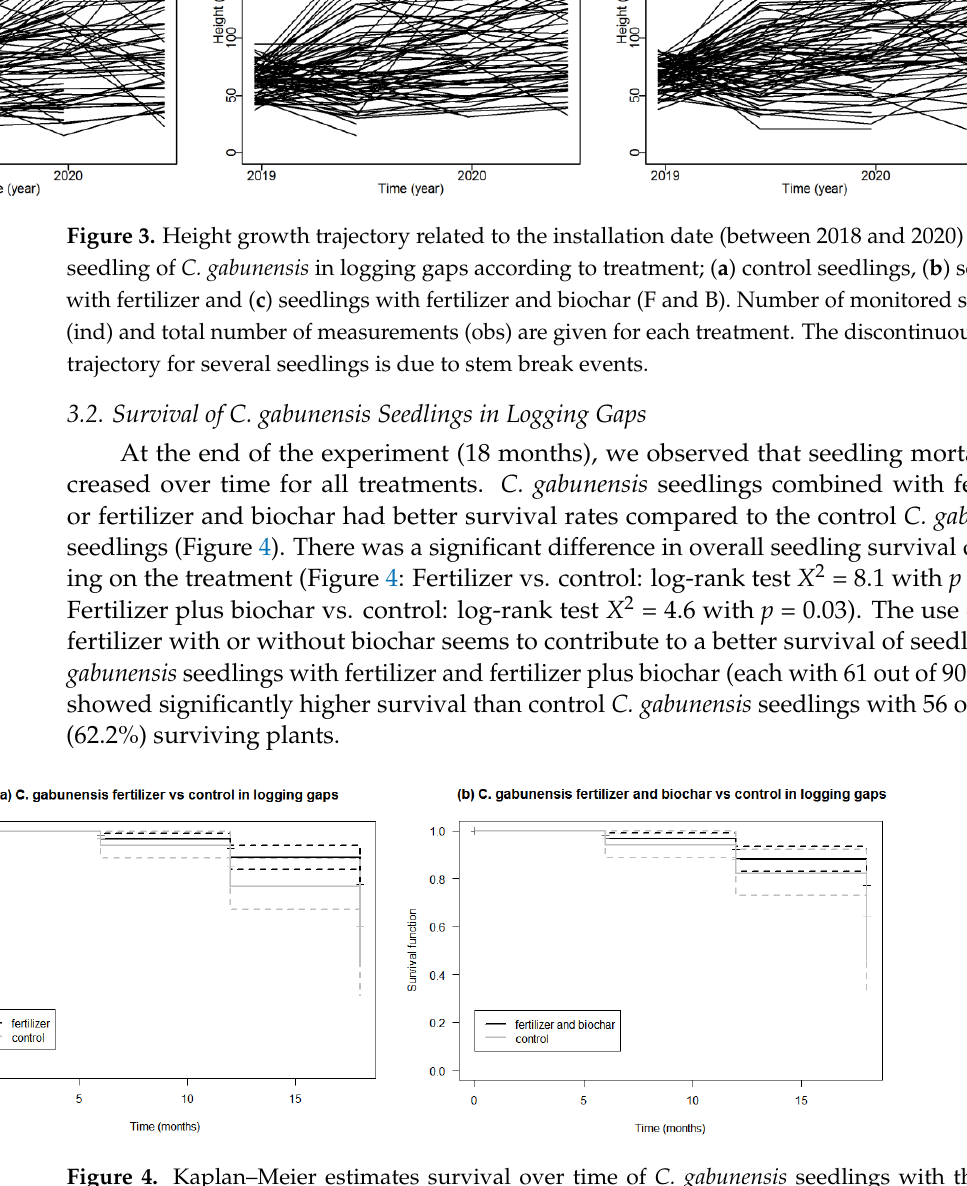
Figure 4. Kaplan–Meier estimates survival over time of C. gabunensis seedlings with their 95% confidence limits, as a function of treatment in logging gaps. ( a ) C. gabunensis seedlings with fertilizer vs. control C. gabunensis seedlings; and ( b ) C. gabunensis seedlings with fertilizer and charcoal vs. control C. gabunensis seedlings.